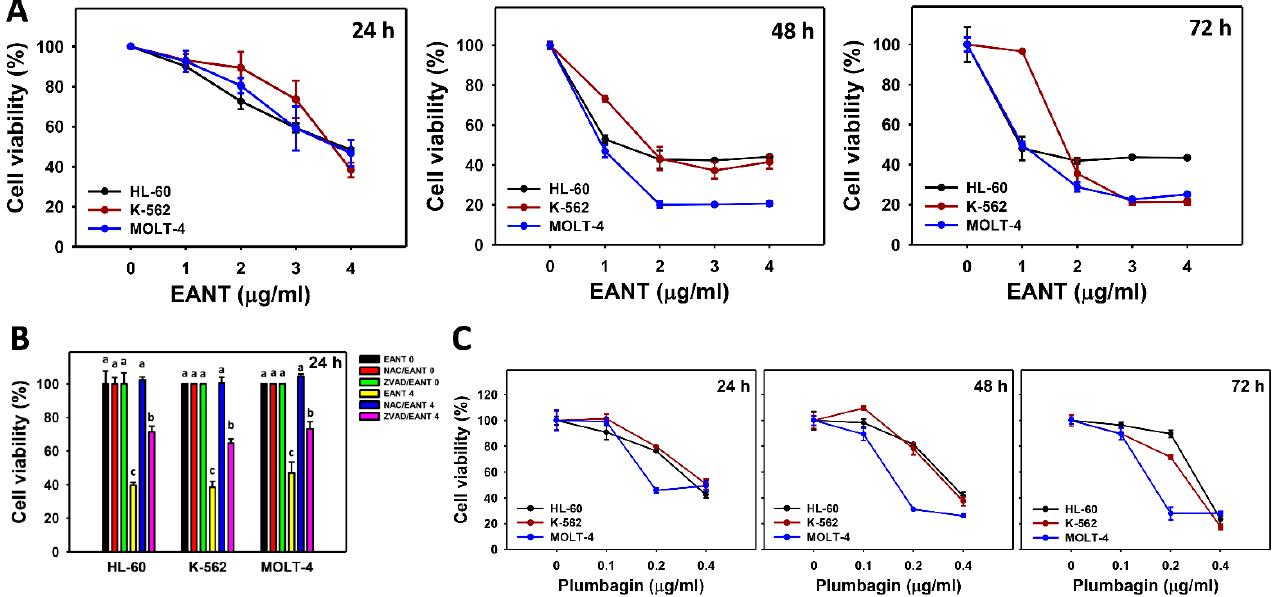
Figure 2. Leukemia cell viabilities following EANT treatment. ( A ) MTS assay at 24, 48, and 72 h. ( B ) Pretreatment impact of NAC and ZVAD on cell viability. Cells (HL-60, K-562, and MOLT-4) were pretreated with NAC (5 mM, 1 h), ZVAD (100 µ M, 2 h), or instead post-treated with EANT (0 and 4 µ g/mL for 24 h). The 0 µ g/mL solution contained no EANT but contained 0.1% DMSO. ( C ) MTS assay at 24, 48, and 72 h for the main isolated compound plumbagin in EANT. Data, mean ± SD ( n = 3). Data showing different alphabets at the top revealed a significant difference ( p < 0.0001 for multiple comparisons). In the example of HL-60 cells (Figure 2B), the EANT 0, NAC/EANT 0, ZVAD/EANT 0, and NAC/EANT 0 show “a”, indicating nonsignificant differences between each other because they overlap with the same lower-case letters. Similarly, the NAC/EANT 0, ZVAD/EANT 4, and EANT 4 showing “a, b, and c” indicate significant differences among each other.